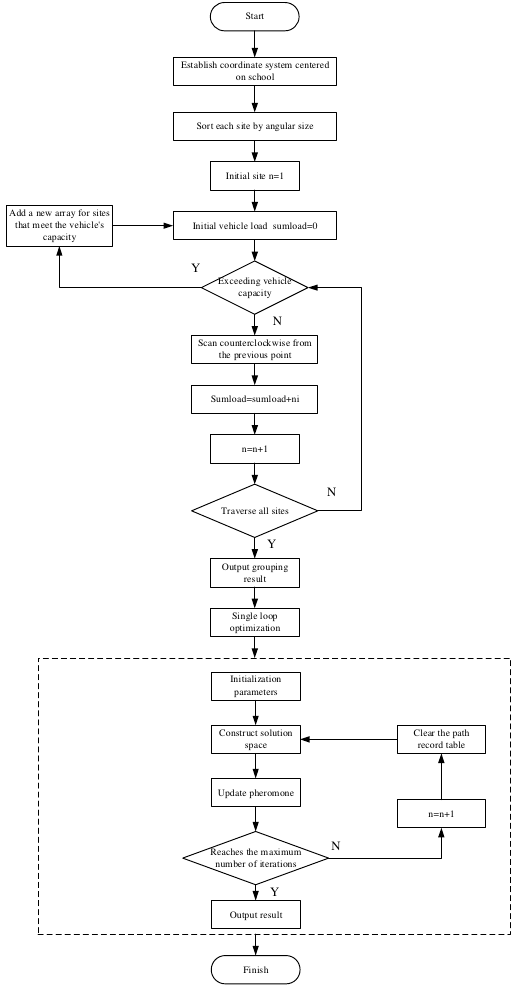
Figure 6. The second stage solution algorithm.